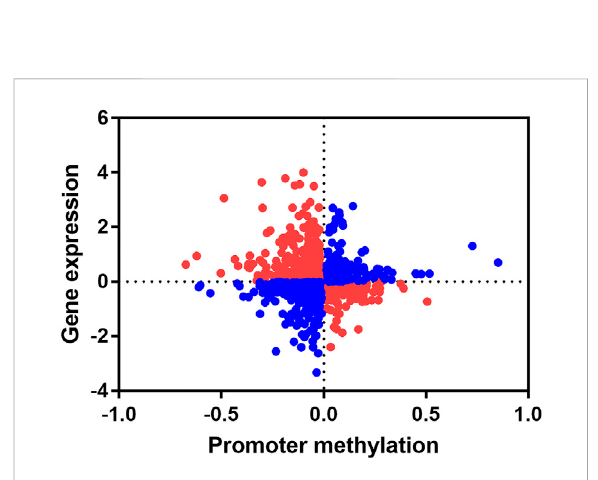
FIGURE 7 Conjoint analysis of promoter methylation level and gene expression level.Each dot represents agene, red indicates that the promoter methylation level is negatively correlated with gene expression level, and blue indicates that the promoter methylation is positively correlated with gene expression